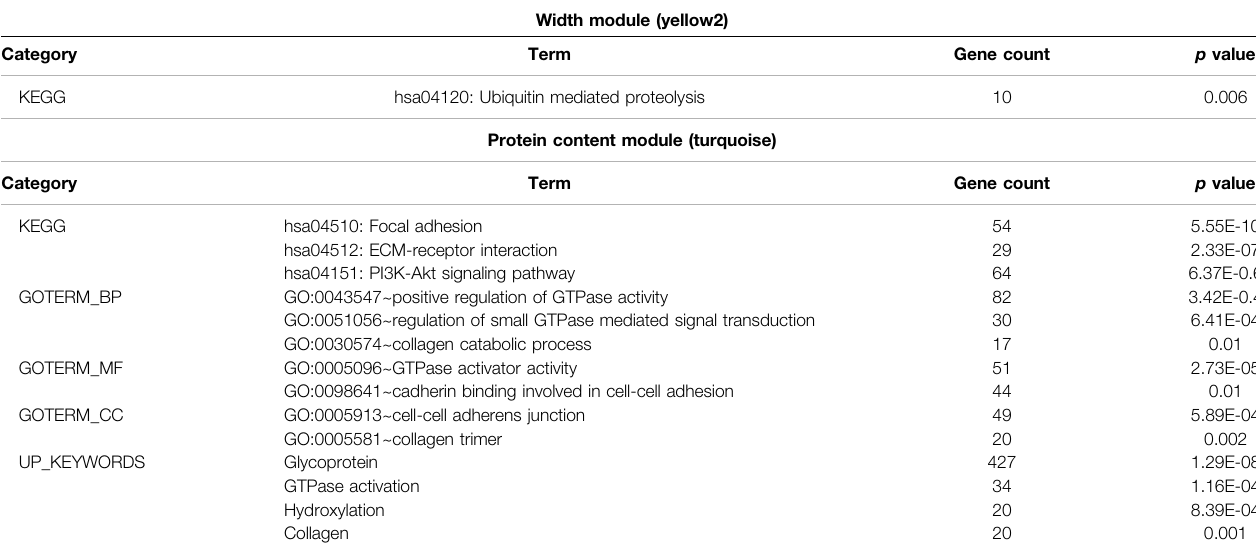
TABLE1| Thesigni fi cantlyenrichedGOterms,KEGGpathwaysandUP_KEYWORDSidenti fi edbyDAVIDtoolsconsideringthegenescomprised inthewidth(yellow2) and protein content (turquoise) modules and whose mRNA level covaried with the crude protein content and breast width in normal and White Striping/Wooden Breast affected Pectoralis major muscles in 52-day-old broilers. Benjamini-adjusted p value < 0.05 was chosen as the signi fi cance